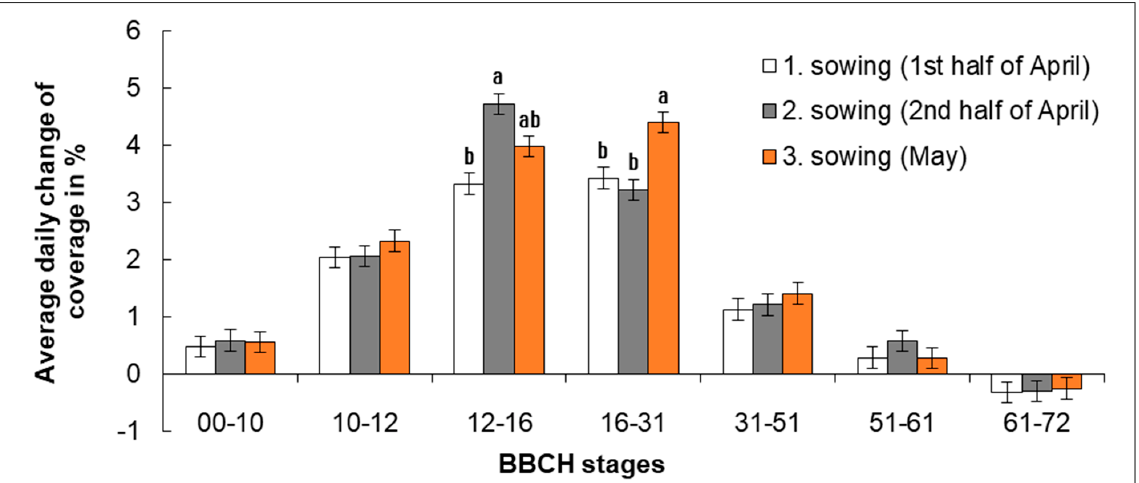
Figure 7. Effect of sowing date on average daily increment of coverage reached between individual BBCH developmental stages. Average values ( n = 9) of individual variants are shown for the specific range of BBCH developmental stages in three years of study ± SD. Different letter indices are added only to variants in which significant differences were found ( p < 0.05). If there are no letter indices, no significant differences were found between the individual variants.